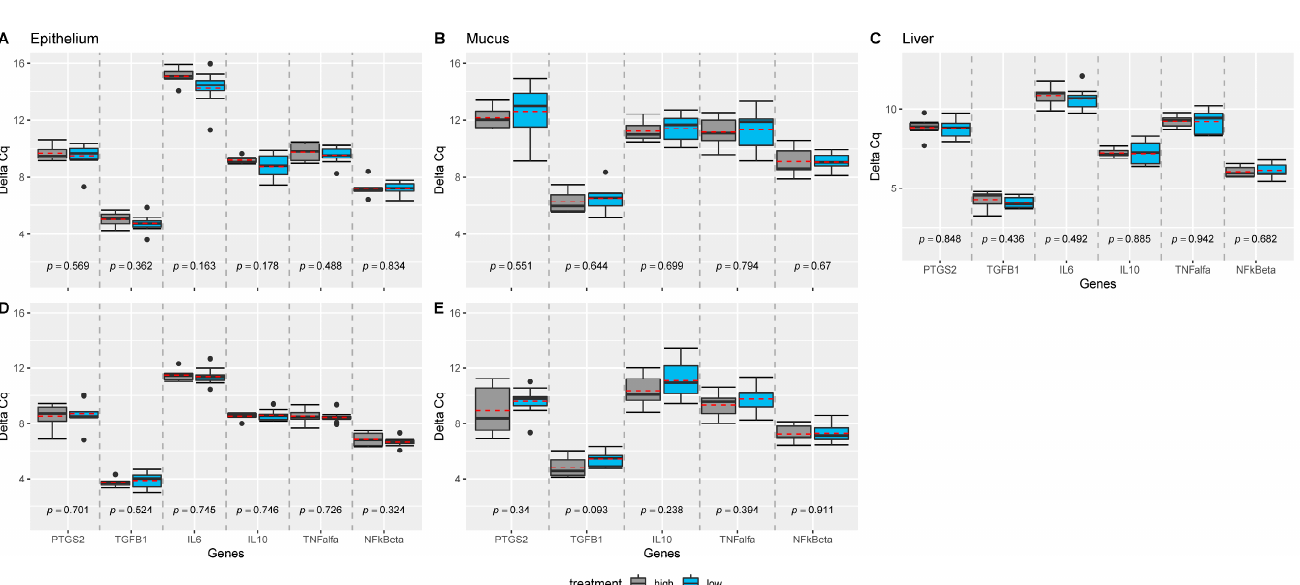
Figure 1. Comparison of treatment effect investigated for each gene, tissue, and ileal sample position, separately. p -values were estimated from mixed effect models with treatment as fixed and sow as random effect using the Satterthwaite’s method. Linear mixed effect model analyses were performed for each gene, tissue, and sample position within tissue, separately, and grouped boxplots including all genes were generated: for ( A ) epithelium samples collected from 50%; ( B ) mucosal samples collected from 50%; ( C ) liver samples, ( D ) epithelium samples collected from 90%; ( E ) mucosal samples collected from 90%. Pairwise comparisons are separated by grey dashed lines. Mean values per group are indicated by red dashed lines. n = 18 piglets.